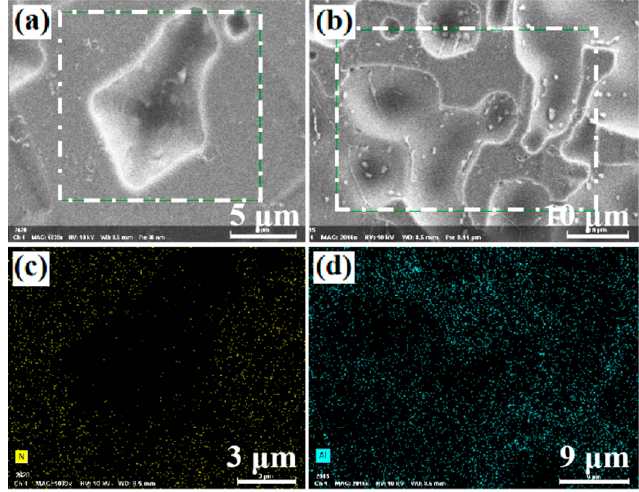
Figure 5. ( a ) and ( b ) scanning electron microscope (SEM) surface images of the reacted areas after the Al paste 1 had been etched; ( c ) and ( d ) element mapping for nitrogen and Al at the reacted areas shown in ( a ) and ( b ), respectively.